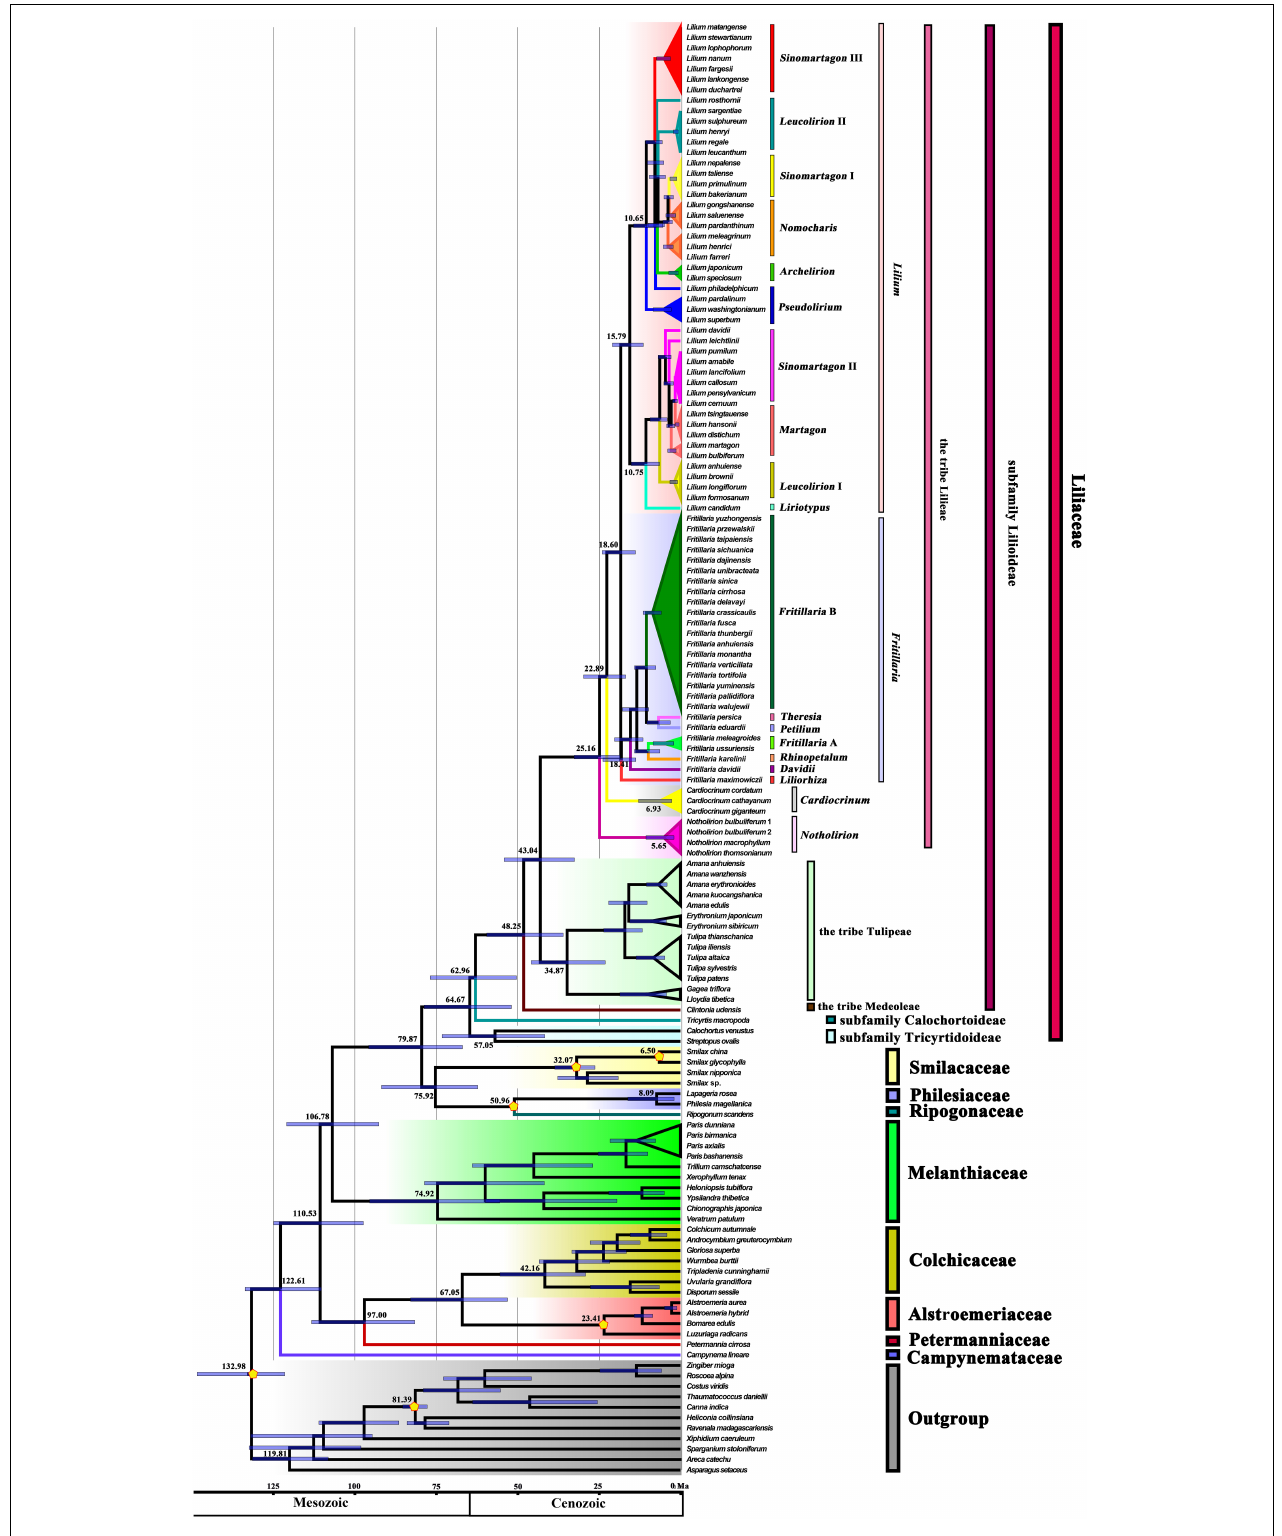
FIGURE 2 | The estimation of divergence time based on 139 plastomes of Liliales and outgroups. The 95% highest posterior density (HPD) estimates for each well-supported clade are represented by bars. The APG (2016) classification is indicated to the right of the tree and colored within the tree. Yellow pentagons indicate six calibration points (see